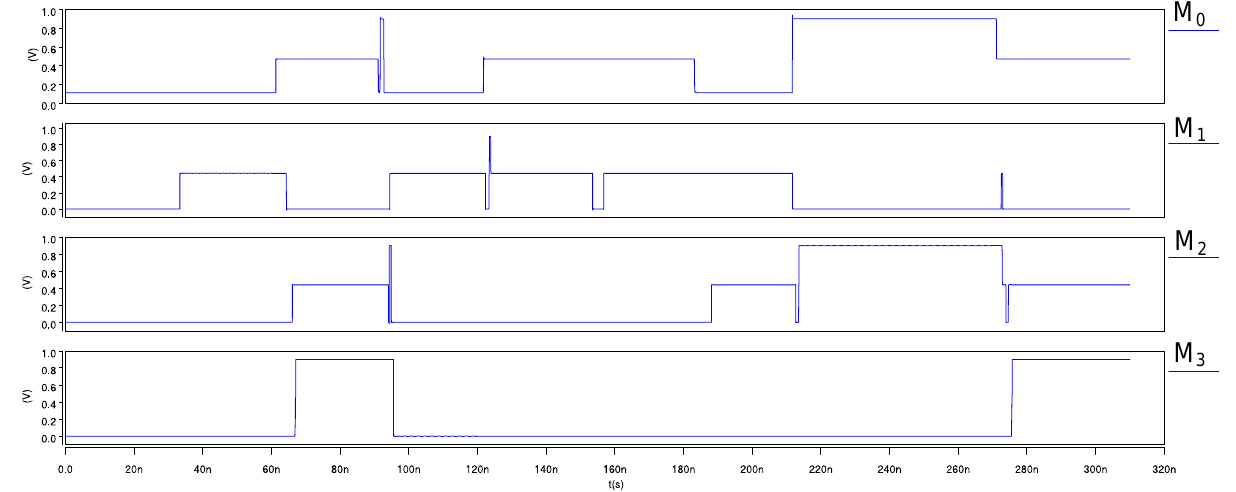
Figure 16. Transient response of 2-trit CNTFET-RRAM ternary multiplier